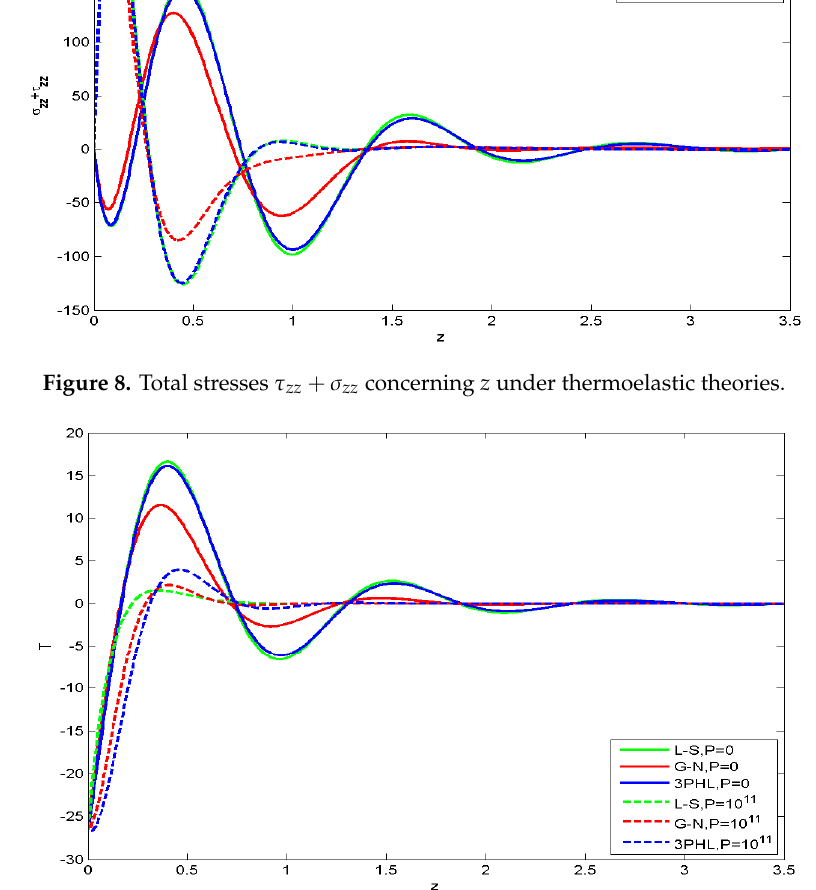
Figure 9. Temperature T concerning z under thermoelastic theories.